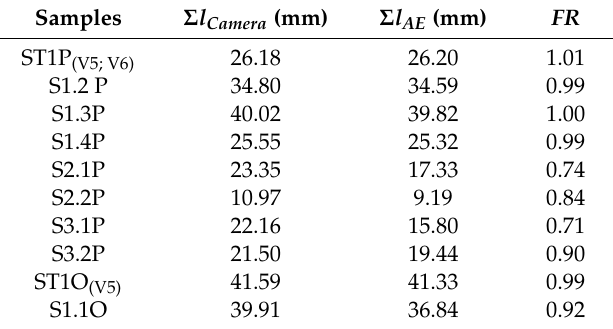
Table 3. Dimension of crack lengths as observed by the camera (true crack) and by the AE system (calculated crack). The factor ratio FR (pure number) is representative of the detection quality of the AE in terms of elastic energy released during the brittle